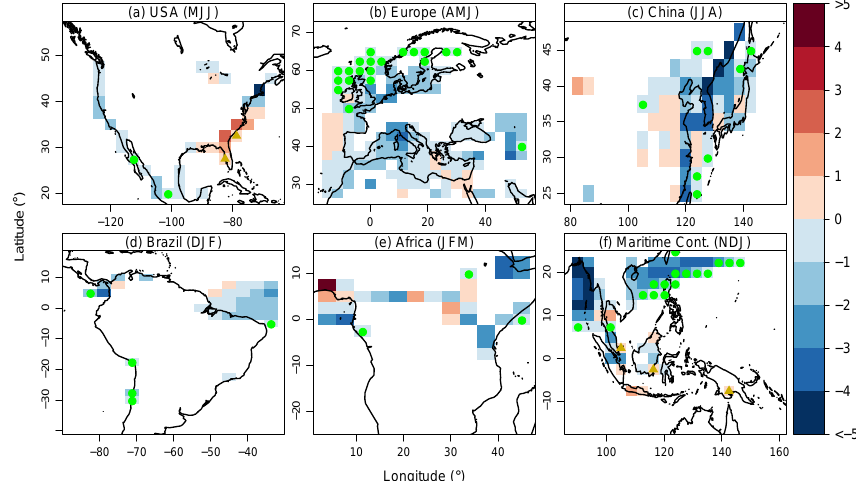
Fig. 8. Change in AOT40 > 3ppmh during the daylights hours of the regional three-month growing season caused by cropland expansion. Growing seasons are quoted, e.g. MJJ=May, June, July. White areas are where both without and with cropland expansion the AOT40 is below the threshold. Green circles indicate crossing to below the threshold. Gold triangles indicate crossing to above the threshold.